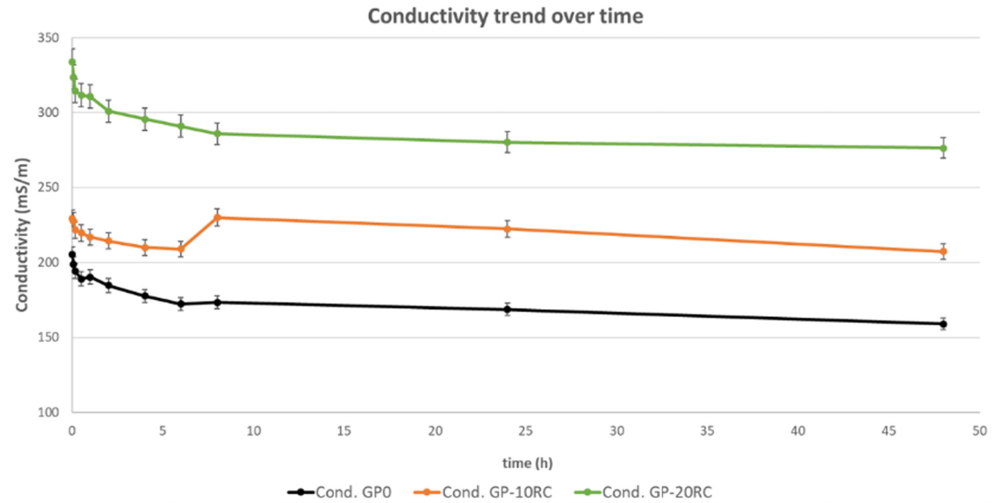
Figure 2. Ionic conductivity of the eluate (1:10 = solid:water weight ratio) vs. immersion time of the three geopolymers cured 28 d. (The reproducibility of the test was calculated to be within an error of 8%.)